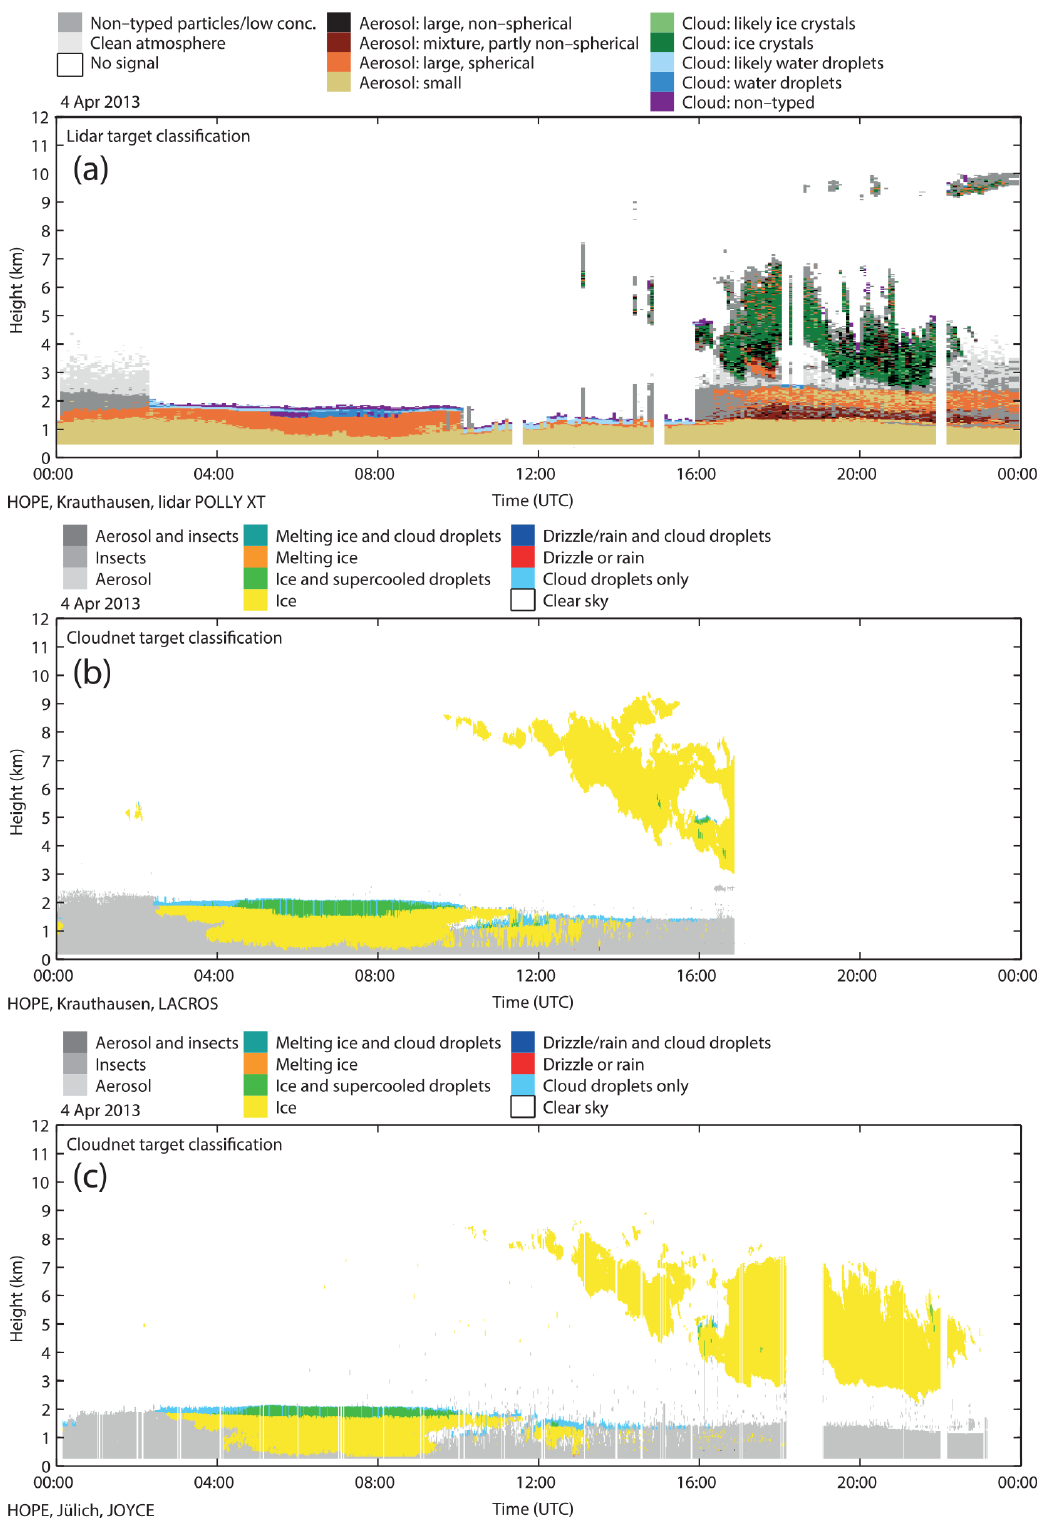
Figure 10. Lidar particle categorization (a) and Cloudnet target categorization ( b and c ) for 4 April 2013 at Krauthausen and